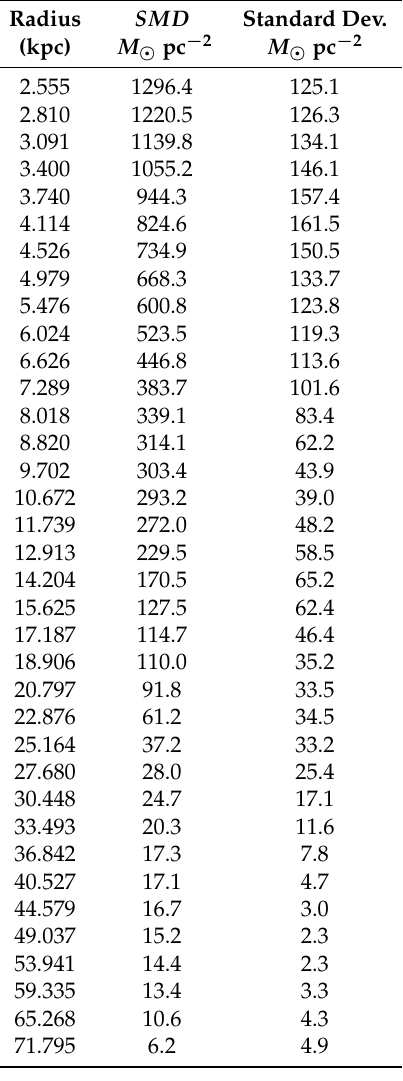
Table A4. Continued from Table